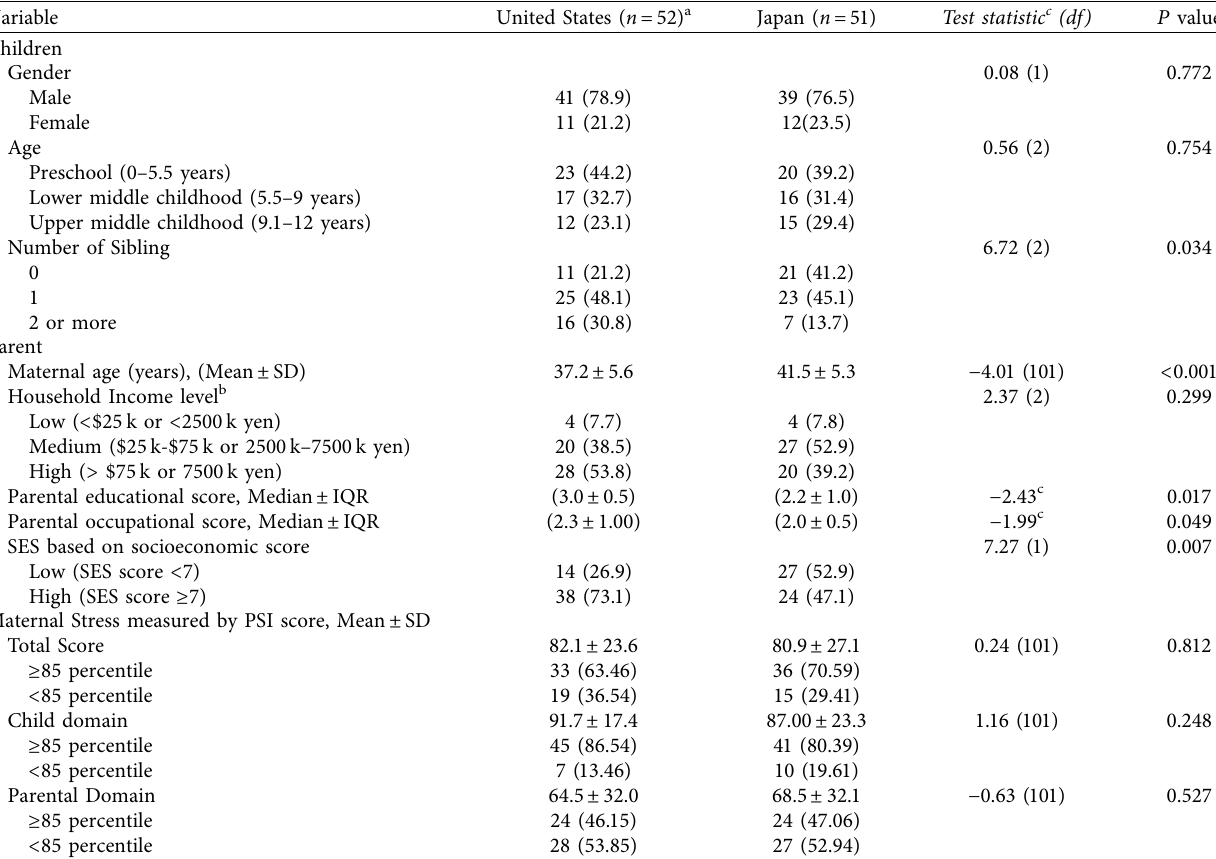
Table 1: Comparison of child and parent characteristics in the U.S. and Japan.